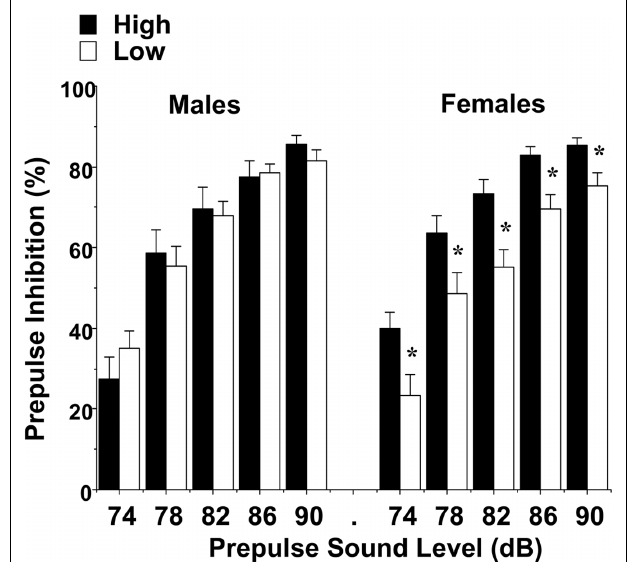
FIGURE 9 | Impaired prepulse inhibition of acoustic startle responses in female offspring of dams with low levels of pup-licking. Data shown are means ( ± SEM) for each group. * p <